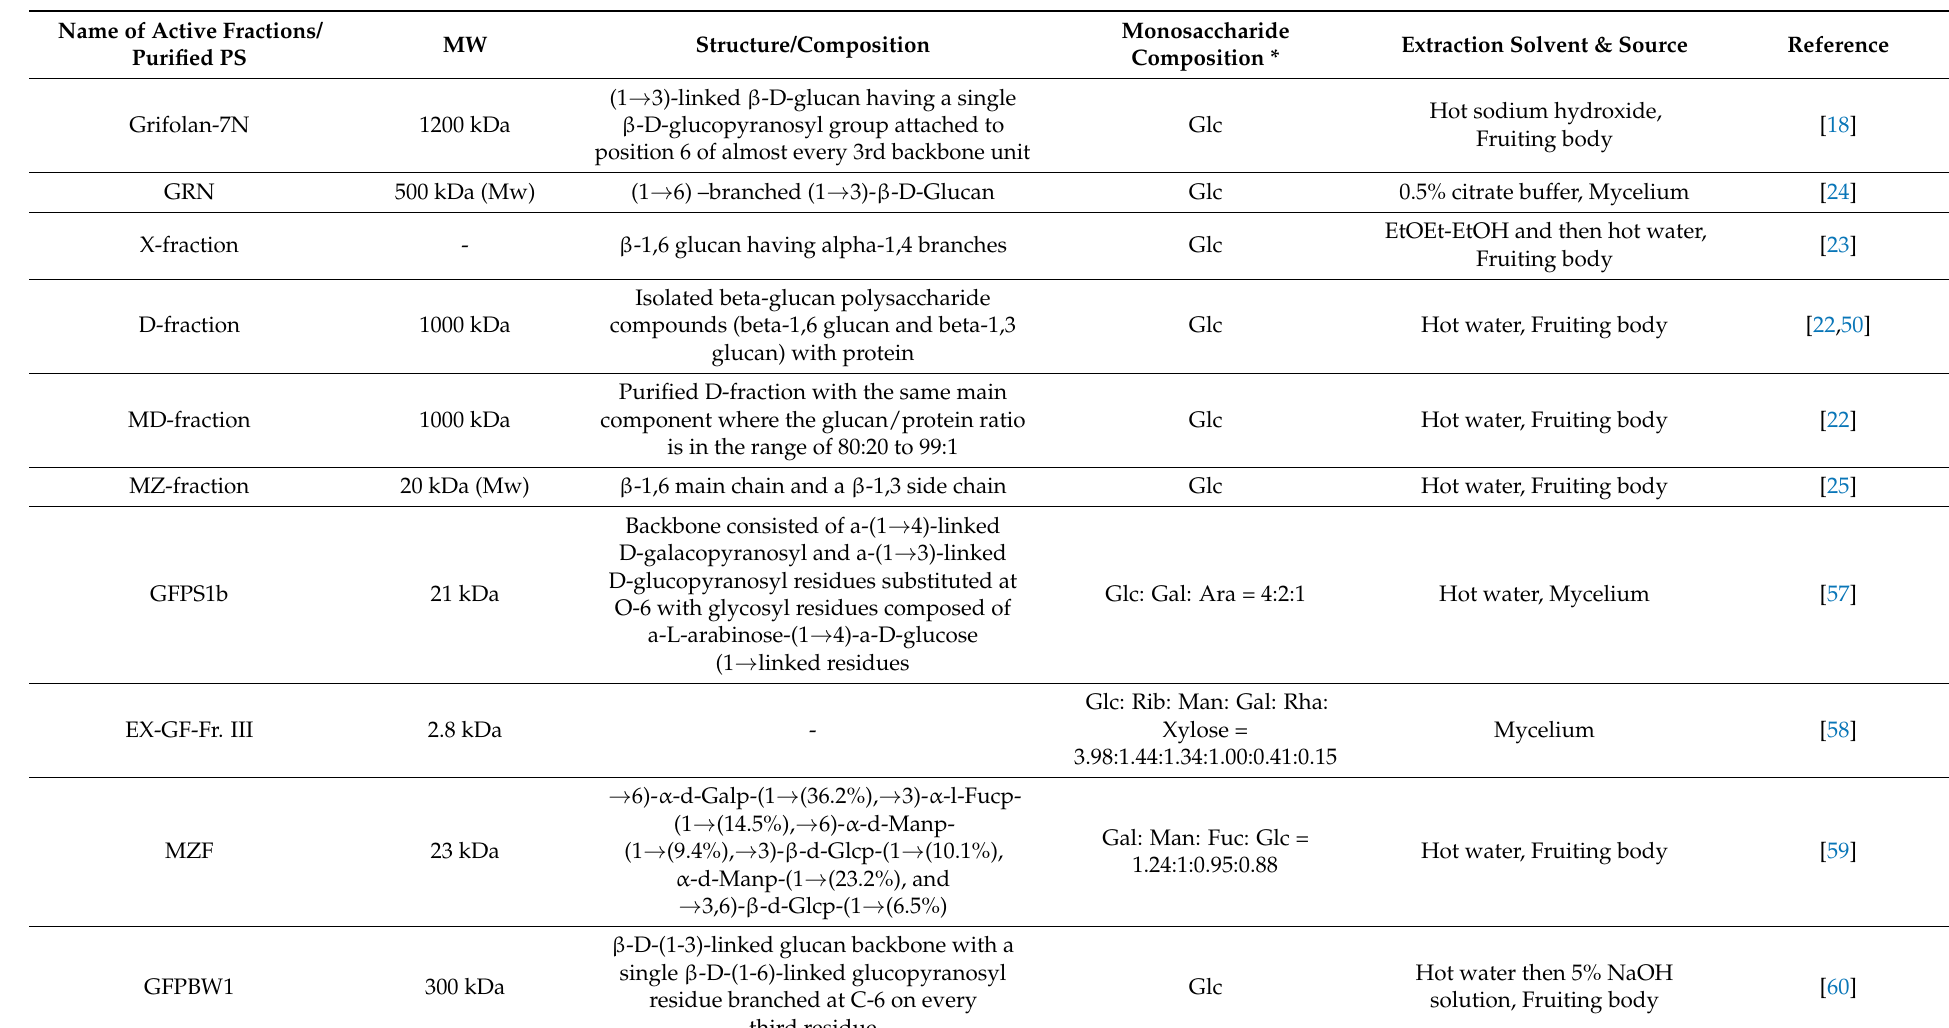
Table 4. Bioactive polysaccharide fractions isolated from G. frondosa with significant medicinal values. Name of Active